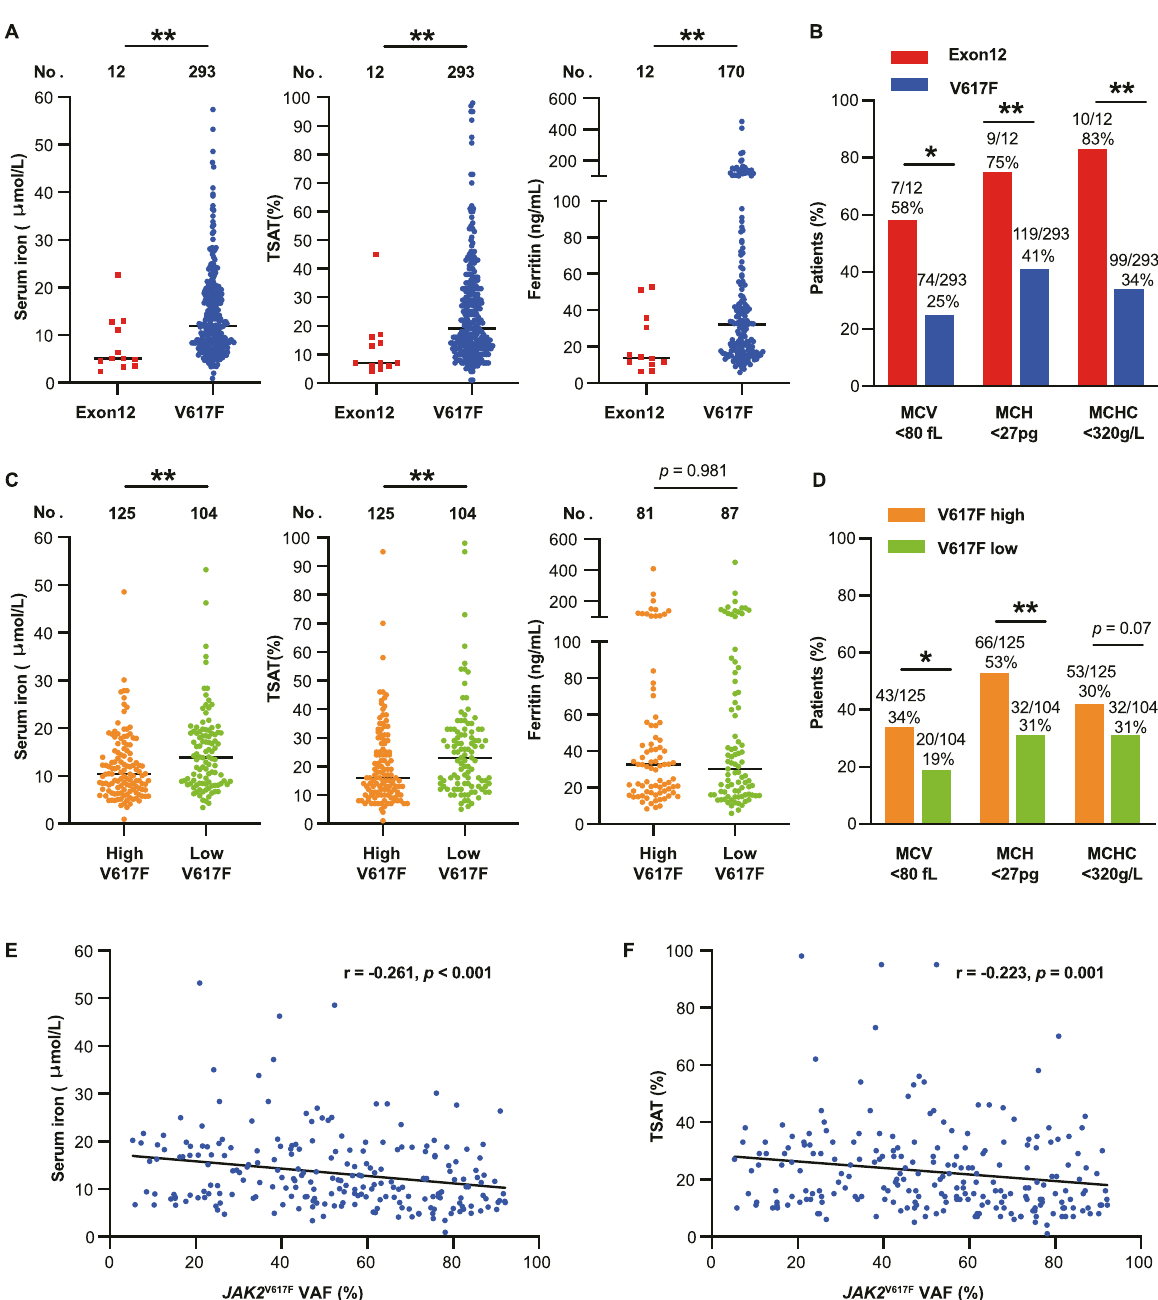
Blood Cancer Journal (2021)